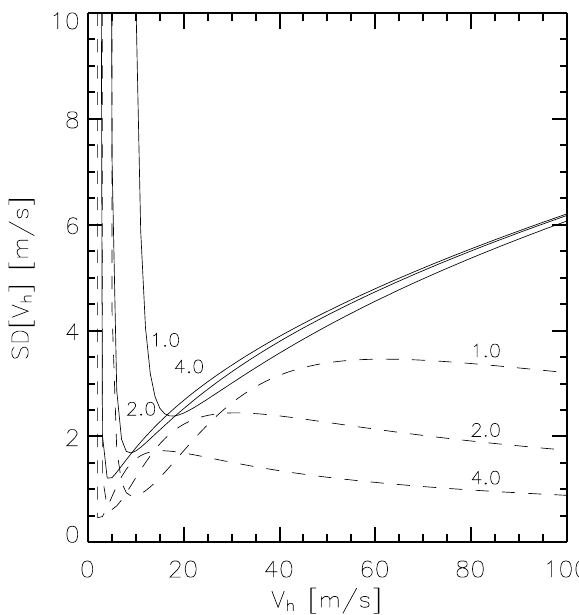
Fig. 4. The effect of wind speed on variance of the wind. T 0 . 5 is varied as before. Results for baseline pair ( B 13 ,B 12 ) is shown in sold lines while results for baseline pairs ( B 12 ,B 23 ) and ( B 13 ,B 23 ) are shown in dashed lines. T d =175.1s, ξ x 0 =52m, B ij